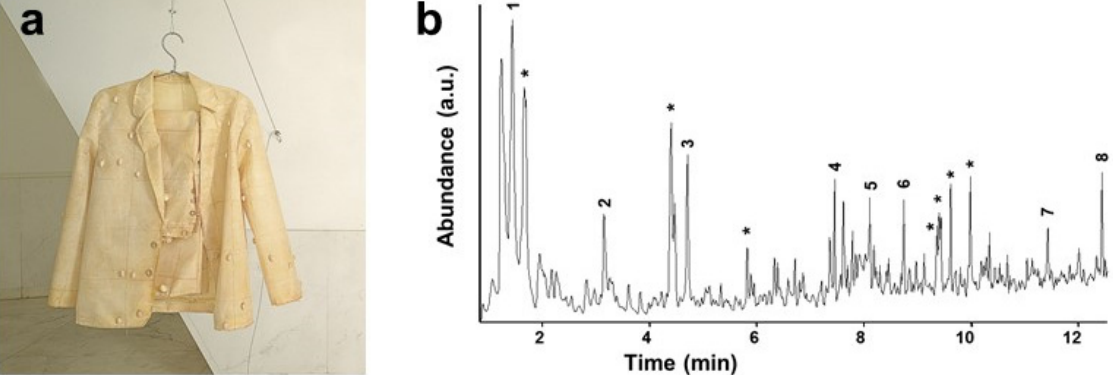
Figure 7. “Traxe de home” (1996) by A. Pinal ( a ) and py-GC/MS chromatogram of the latex textile (direct pyrolysis at 600 °C) ( b ). MS identified the peaks as: isoprene ( 1 ), toluene ( 2 ), xylene ( 3 ), dimeric isoprenes ( 4 – 6 ) and trimeric isoprenes ( 7 , 8 ). Asterisks denote aliphatic or aromatic alcohols, aldehydes and ketones. Image reprinted with permission from [30].